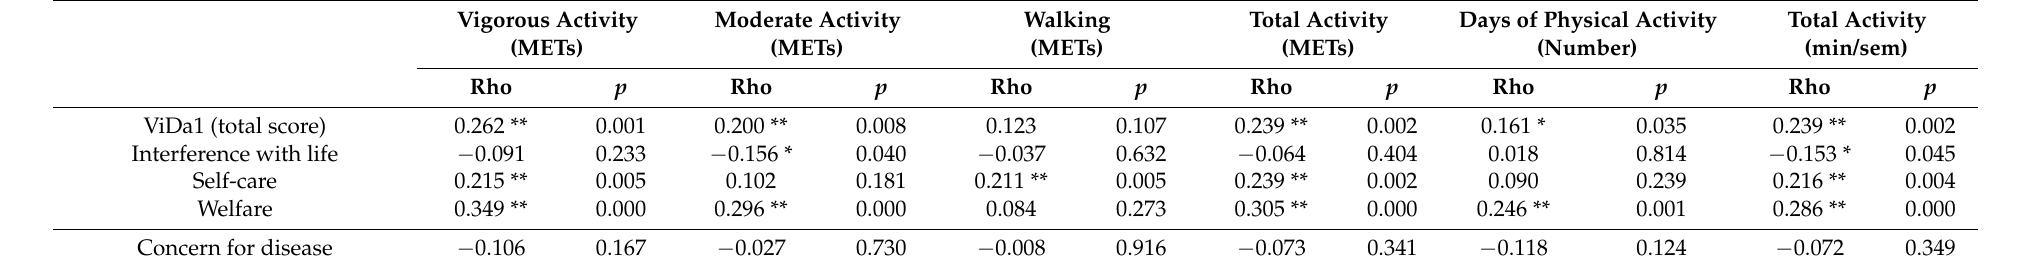
Table 3. Correlations between ViDa1 and IPAQ questionnaires in the Type 1 Diabetes Mellitus population ( n =